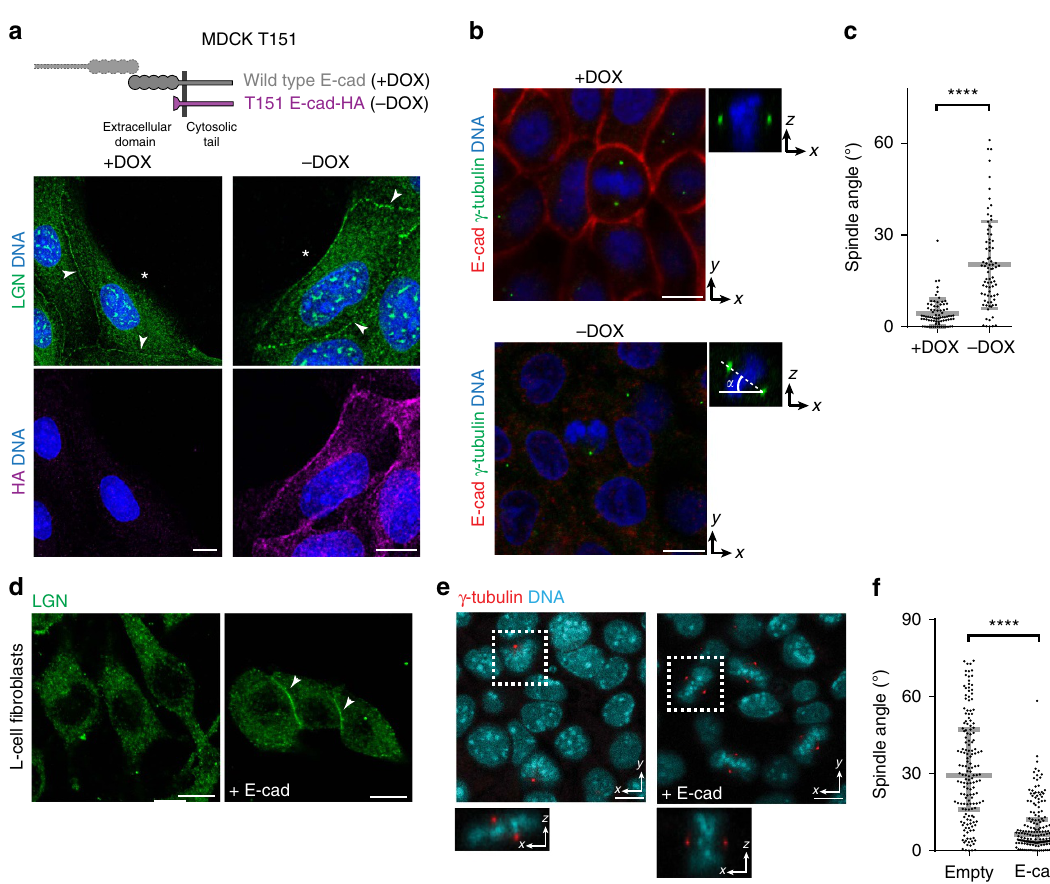
Figure 2 | E-cadherin is an instructive cue for mitotic spindle orientation. ( a ) Schematic representations of full-length and T151 truncated E-cadherin (under control of the doxycycline (DOX) repressible promotor). Immunostaining of endogenous LGN and the HA-tagged T151 E-cadherin ( (cid:2) DOX) showing that the plasma membrane localization of LGN is no longer restricted to cell–cell contacts (arrowheads) but also localizes at membranes not in contact with neighbouring cells as well (asterisks). ( b ) Confocal images of g -tubulin labelled centrosomes in MDCK T151 cells showing the orientation of the mitotic spindle in metaphase. ( c ) Quantification of mitotic spindle angle relative to the basal surface in MDCK T151 cells. ( d ) Localization of LGN in L-cells in the absence or presence of ectopic E-cadherin (E-cad). ( e ) Confocal images of g -tubulin labelled centrosomes in L-cells, showing the orientation of the mitotic spindle in metaphase, in the absence or presence of ectopic E-cadherin. ( f ) Quantification of mitotic spindle angle relative to the basal surface in L-cells in the absence (empty vector) or presence of ectopic E-cadherin. Scale bars, 10 m m. Quantified data were pooled from three independent experiments. Grey bars in dot plots show mean ± s.d.; **** P o 0.0001 using Mann–Whitney